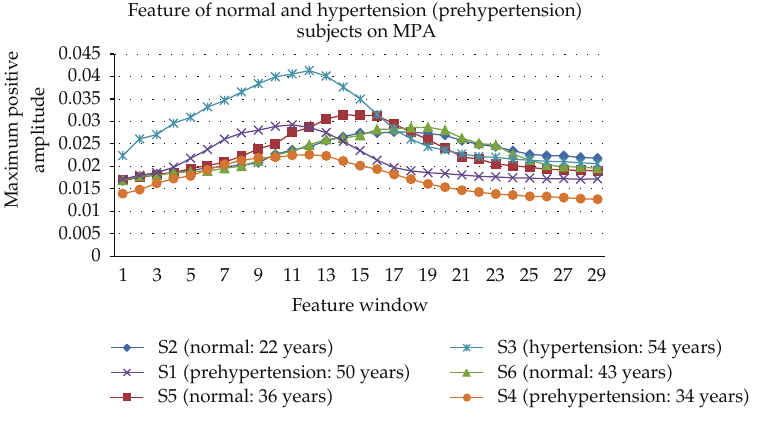
Figure 4: Features extracted with maximum positive amplitude averaged from five readings in the feature windows for normal and hypertension (cid:3) prehypertension (cid:4) subjects with respect to age.